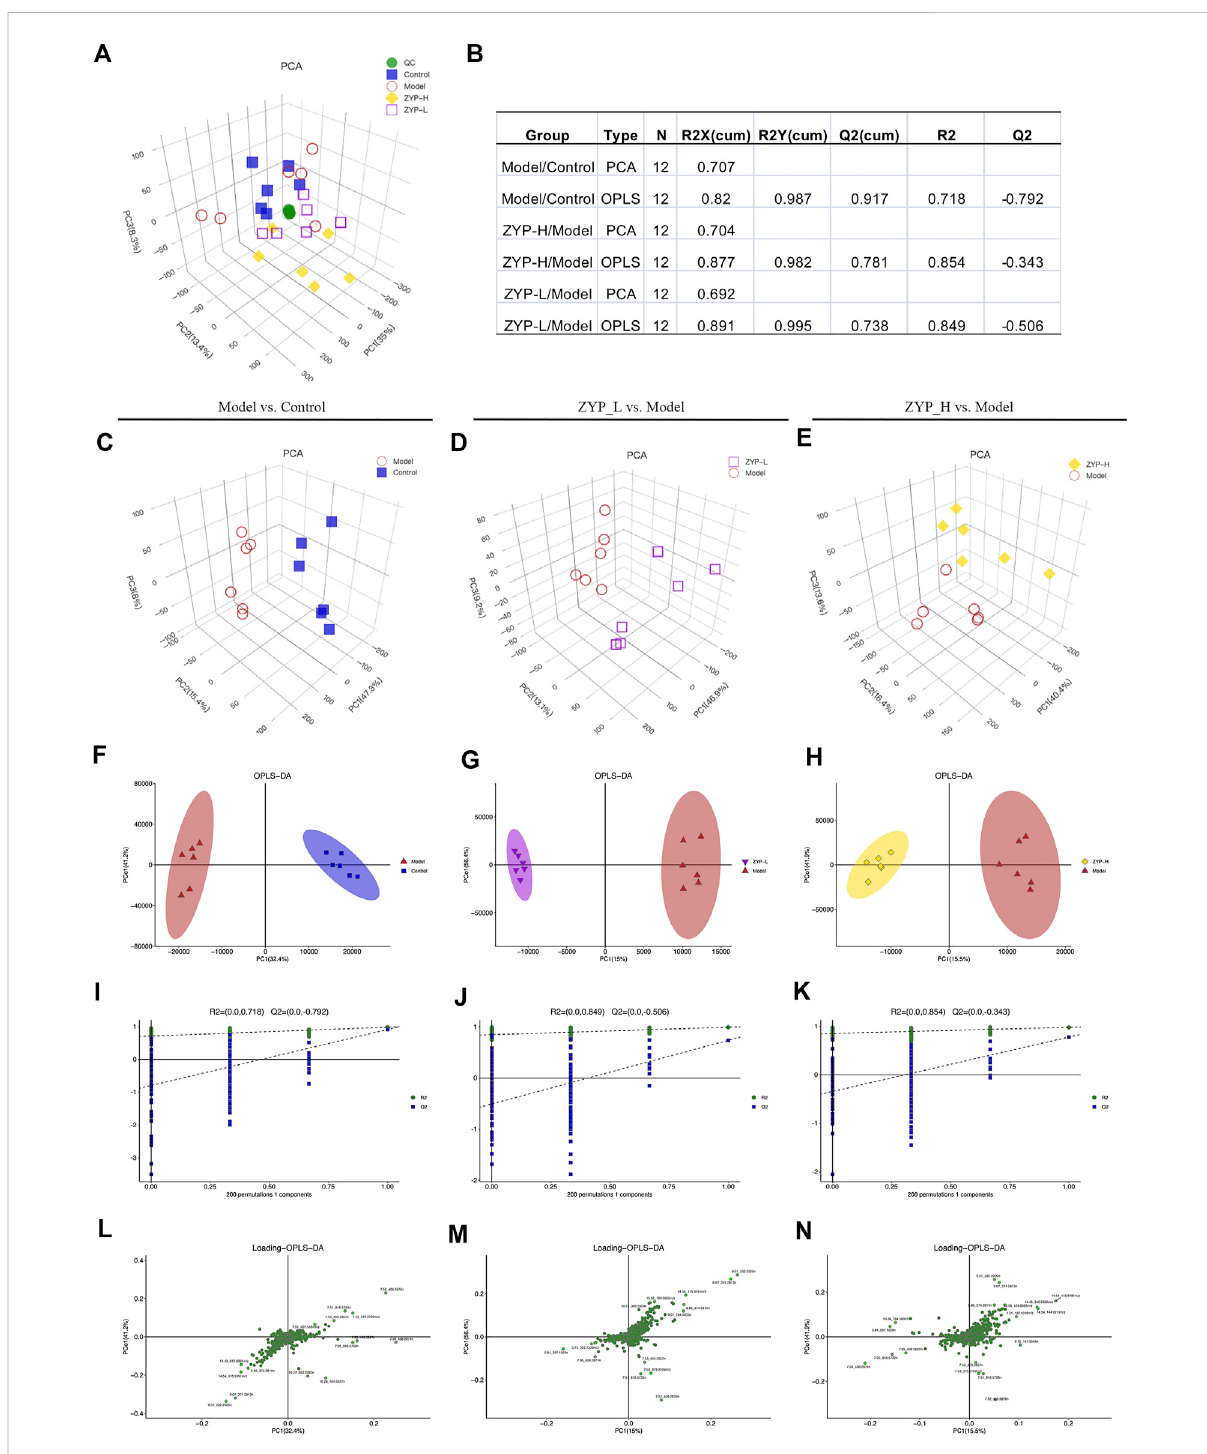
FIGURE 2 Multivariate statistical analysis of metabolic pro fi les derived from the control, model, ZYP_L, and ZYP_H groups. (A) PCA score plot of the control, model, ZYP_L, ZYP_H, and QC groups; (B) Parameters of PCA and OPLS-DA; (C – E) PCA analysis; (F – H) OPLS-DA analysis; (I – K) 200- permutation test; (L – N) OPLS-DA score